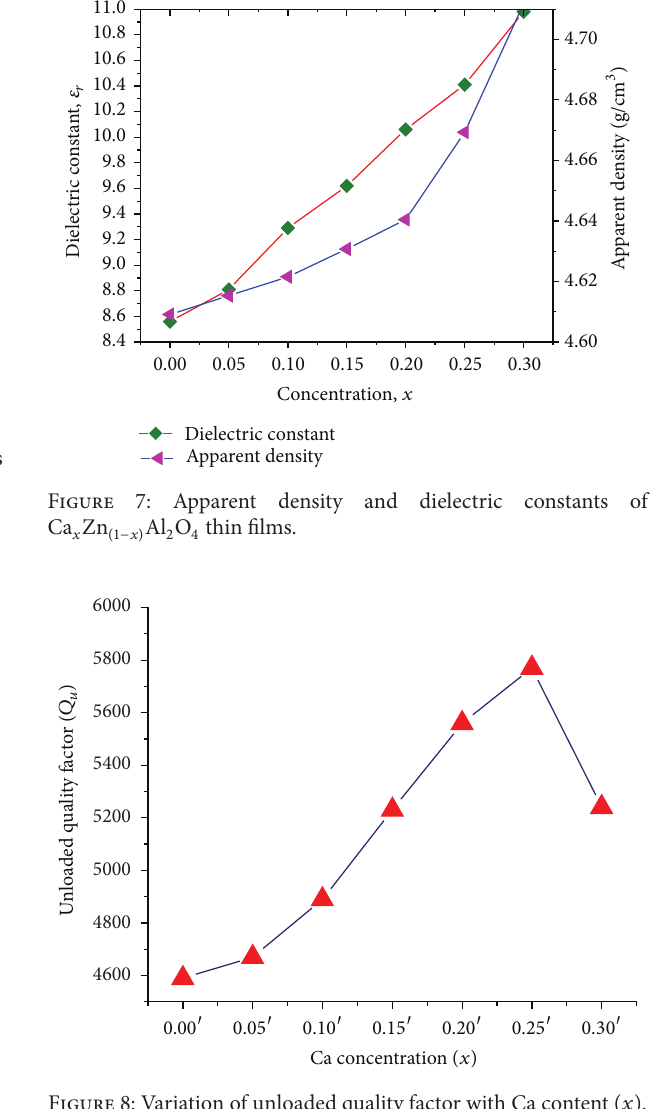
Figure 8: Variation of unloaded quality factor with Ca content ( 𝑥